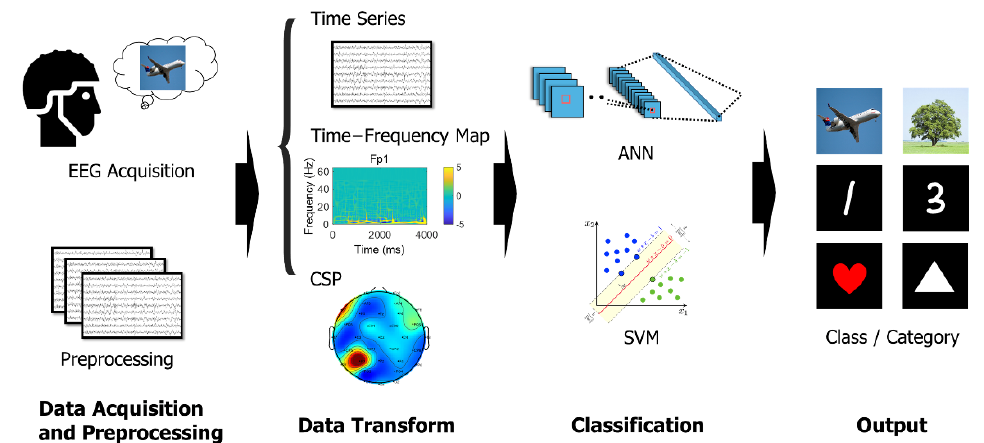
Figure 3. Flowchart describing the detailed procedure of this work. EEG data in the visual perception/imagery experiments were preprocessed and transformed into three types—time series, a time − frequency map, and a CSP feature vector. Each processed data type was trained through artificial neural network (ANN) or the SVM classifier according to each type, and the classification accuracies were compared.